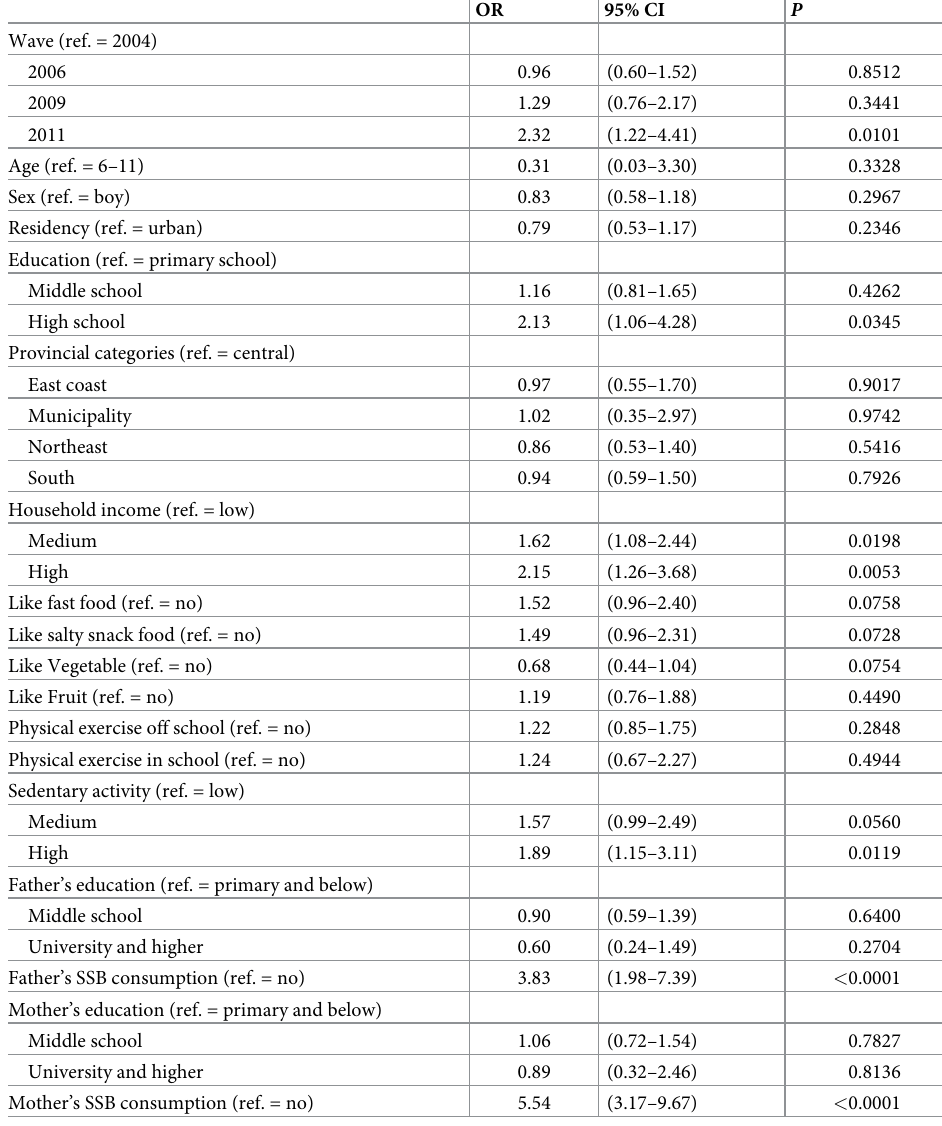
Table 3. Multilevel mixed-effects logistic regression on SSB consumption and associated factors in children in China from 2004 to 2011.